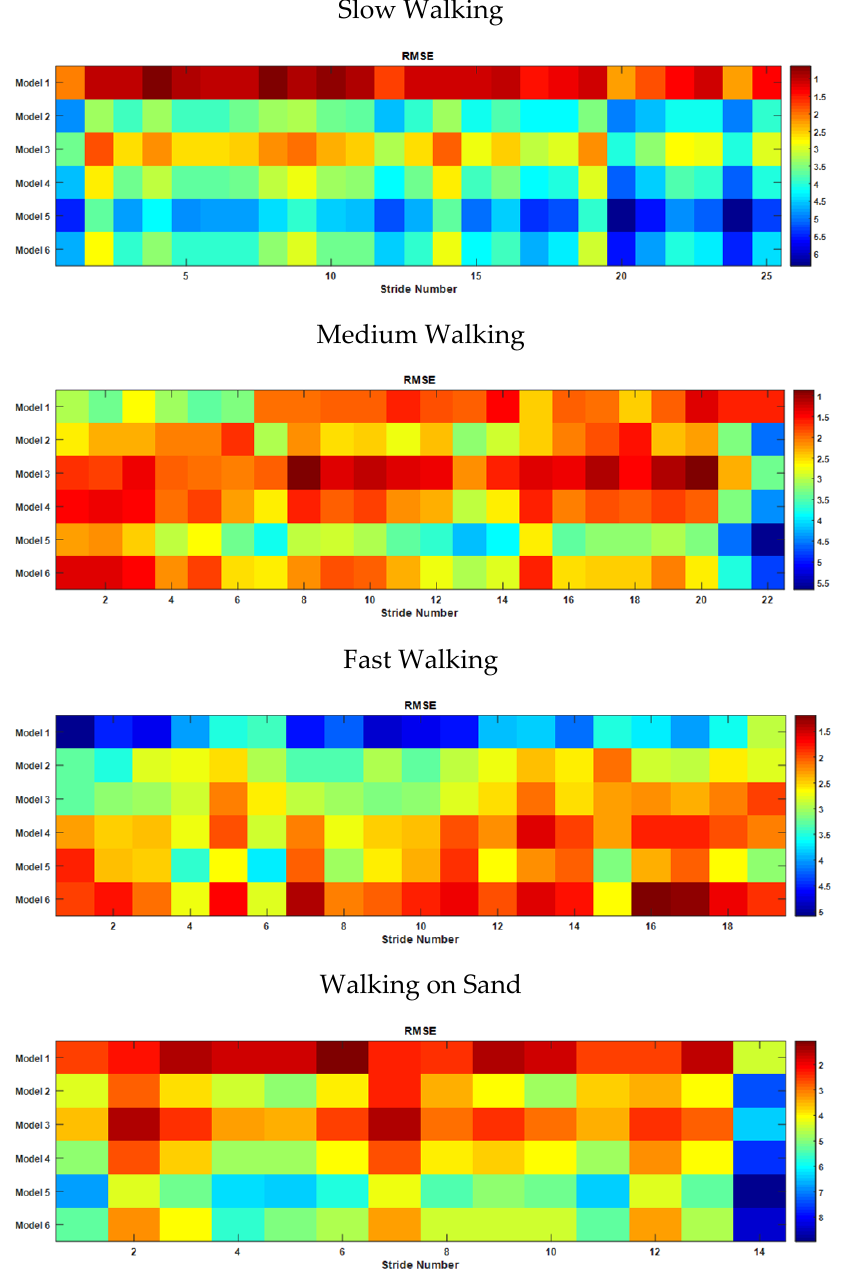
Figure 17. RMSE of each stride with the model-generated waveform for different cases. The same method of classification can be performed using the gyro signal of each stride. As seen in Figure 14, the toe-off point is the point at which the gyro signal is crossed at zero with a positive gradient. The classification performed with gyro signal also gives similar results, as shown in Figure 18. Tis figure shows that the stride pattern here is closer to Model 1 than the others. The full set looks similar to the one for the thigh angle. The full set is not included in Figure 18 to reduce the complexity. This indicates that classification and reconstruction can be performed using the gyro